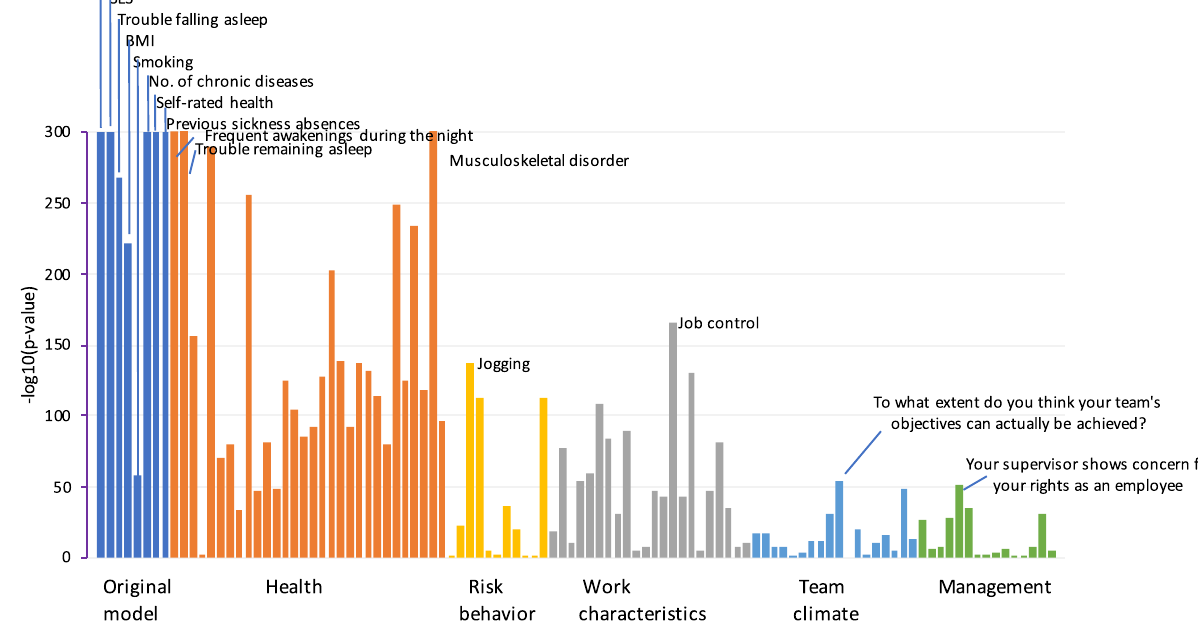
Figure 3. Bivariate unadjusted associations between predictors at baseline and work disability at follow-up in all participants with and without chronic disease at baseline. Bars represent -LOG10(p-value) and are cut at the maximum value of 300.